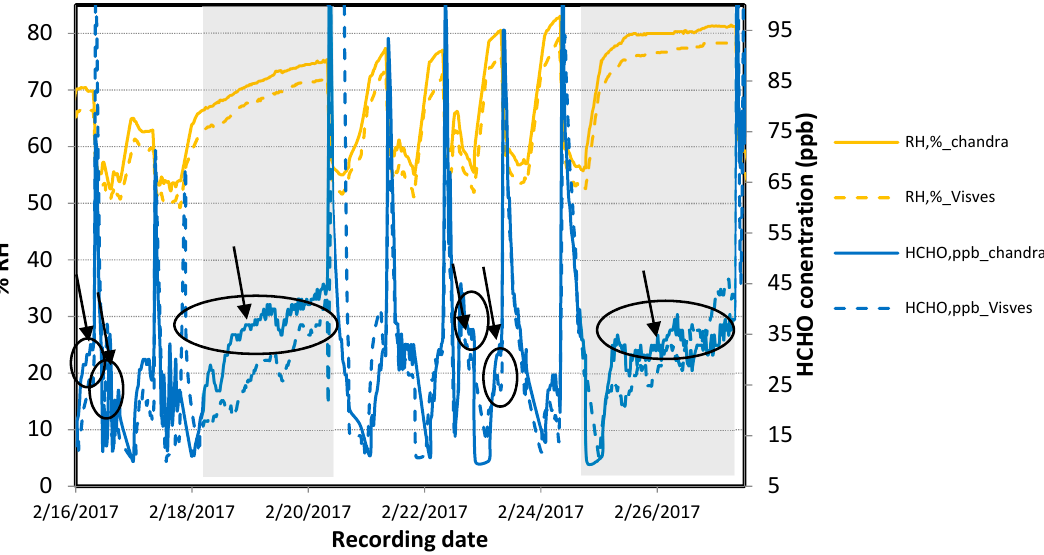
Figure 14. Continuous monitoring in Visvesvaraya and Chandrasekhar meeting rooms (zoom). DNPH passive sampling periods are indicated by a black circle and a black arrow; weekends are highlighted in grey. Table 3. Comparison of formaldehyde concentrations as indicated by Sensor C1 and reference DNPH passive sampling in Chandrasekhar and Visvesvaraya meeting rooms.